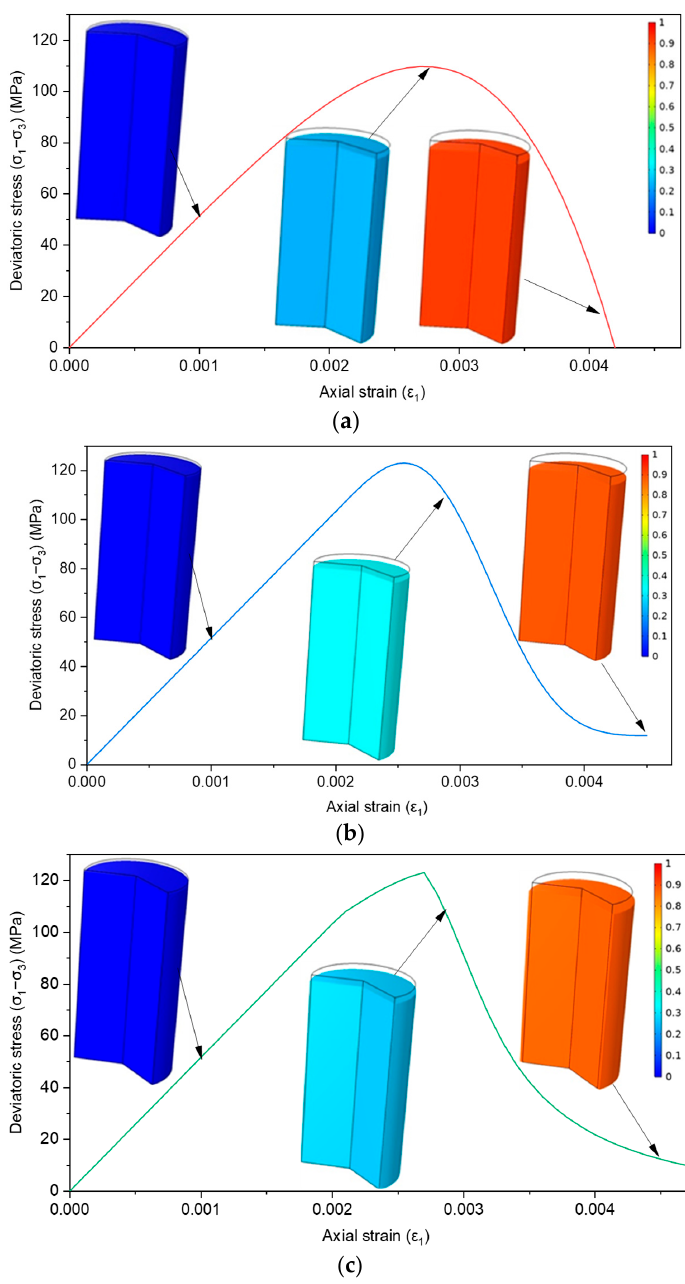
Figure 5. The damage distribution and evolution of different models under uniform compression